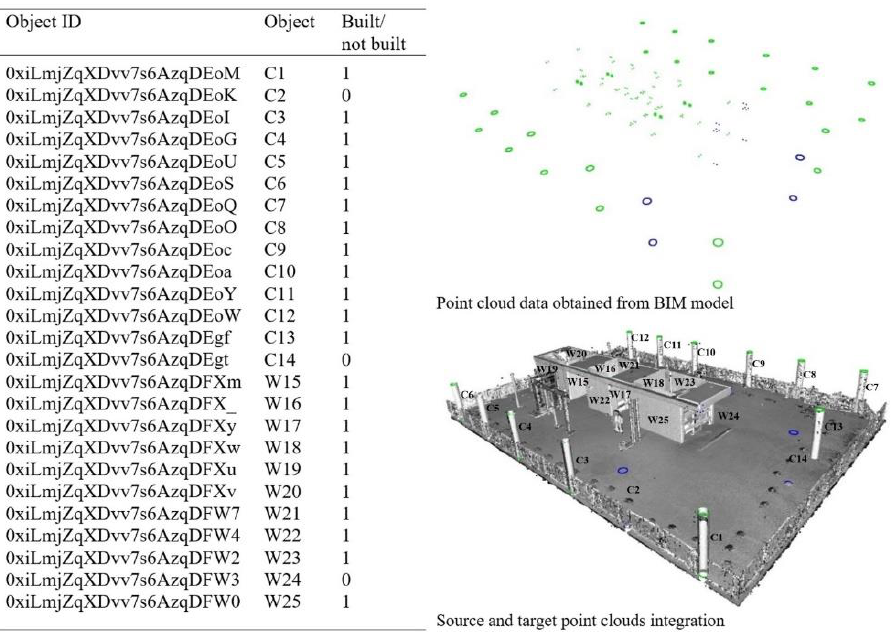
Figure 17. Reporting and visualization of results.